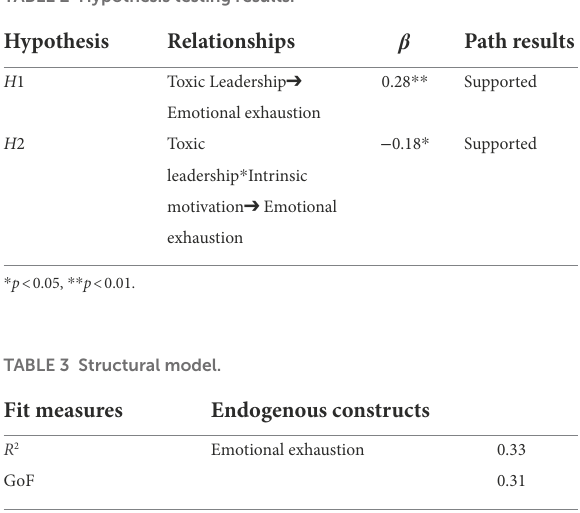
TABLE 2 Hypothesis testing results.